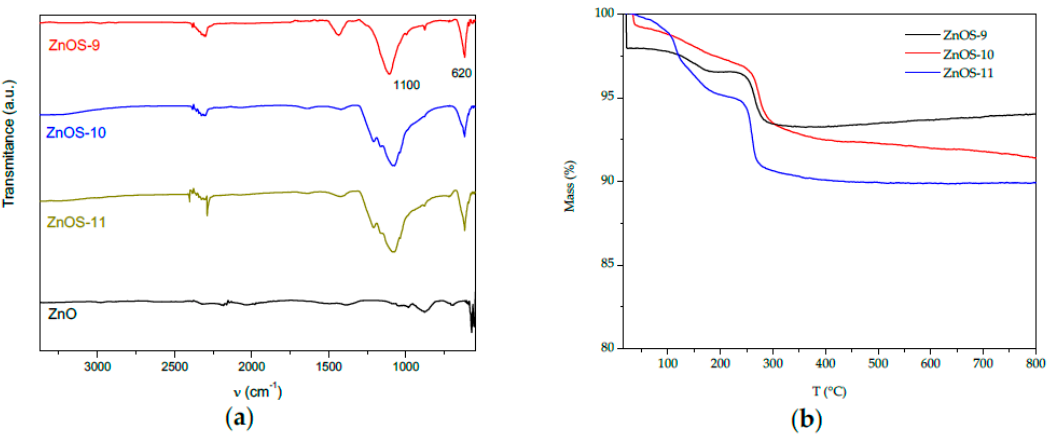
Figure 2. ( a ) FTIR spectra of as-synthesized ZnOS photocatalysts and ZnO, ( b ) TGA for the as-synthesized ZnOS heterostructure materials.